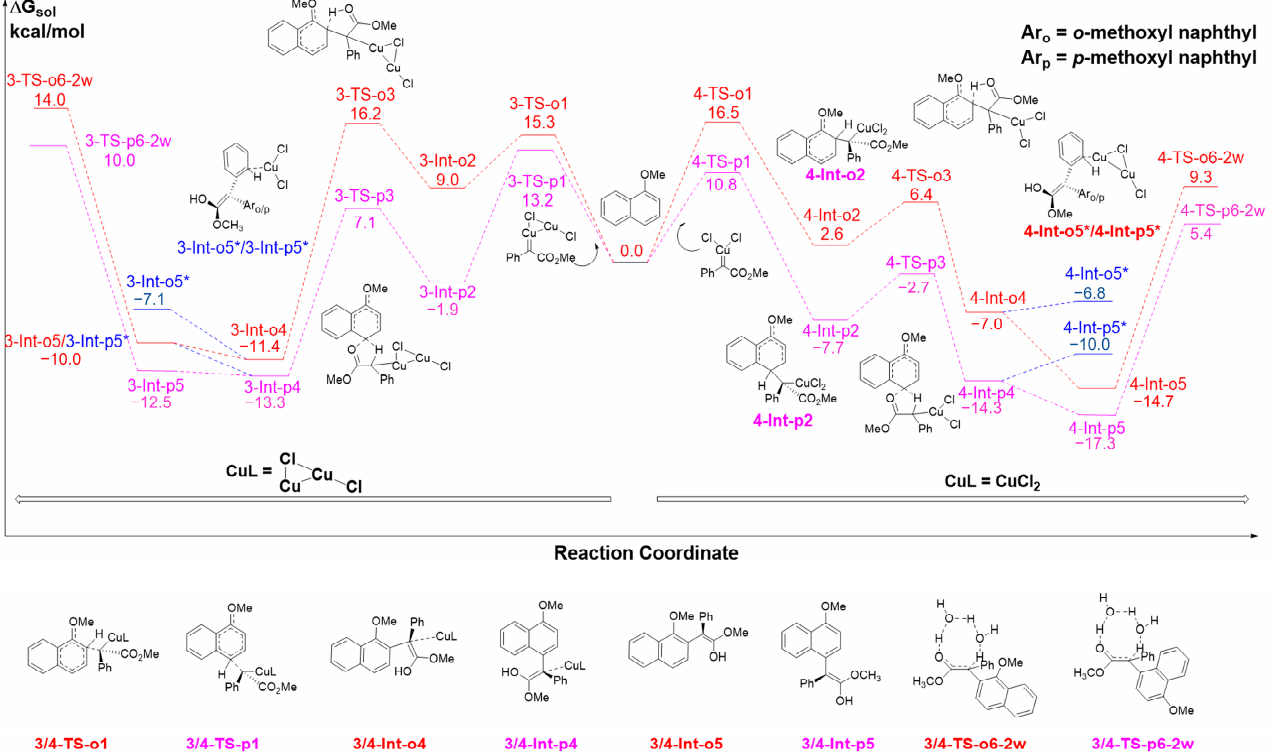
transfer steps at the ortho-positions, are relatively higher than that of the